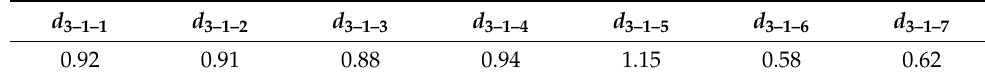
Table 6. Comprehensive entropy value of customer d 3–1